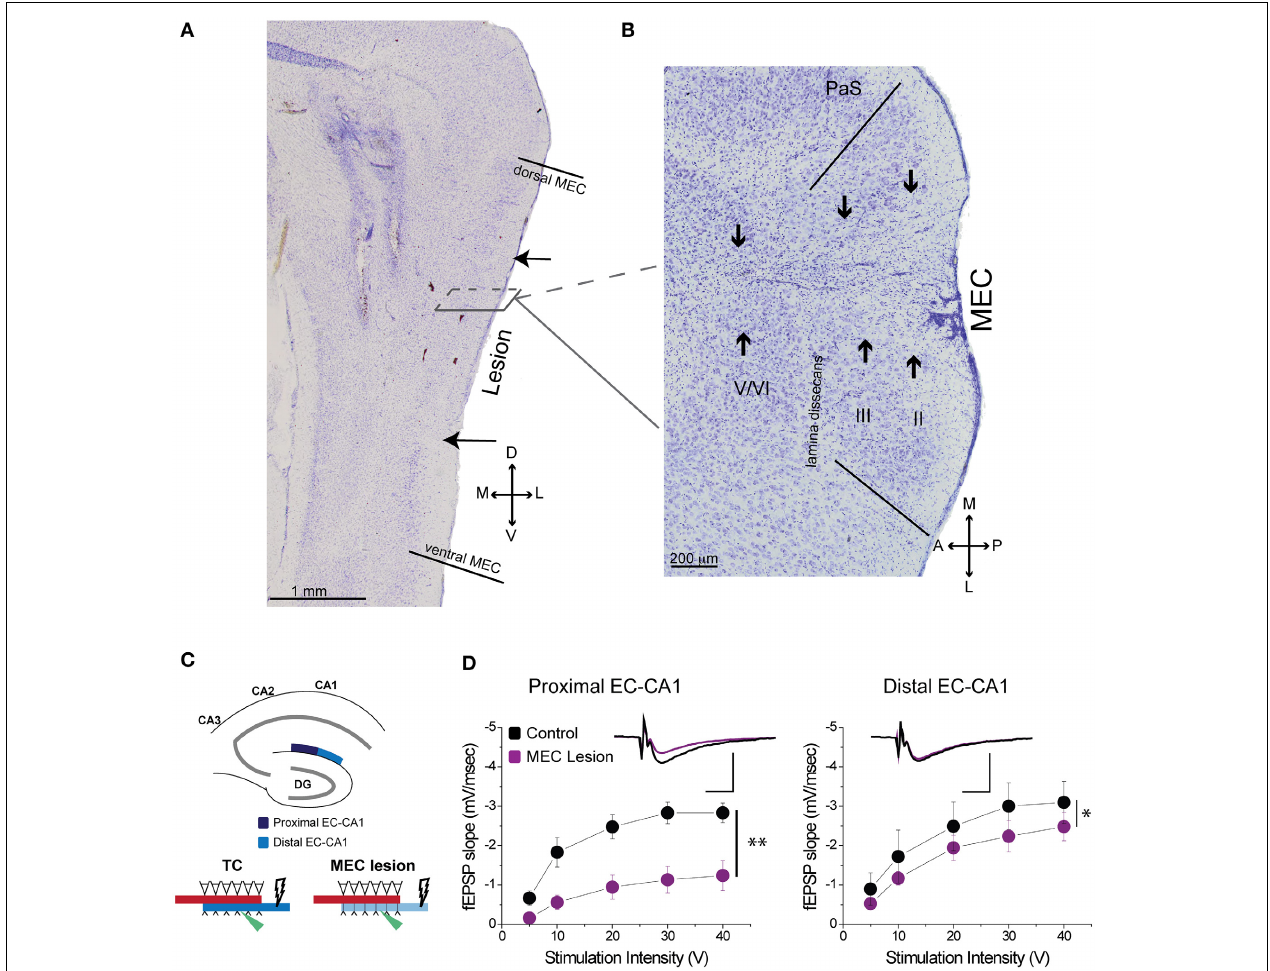
FIGURE 3 | MEC lesions diminished EC-CA1 synaptic transmission in the proximal CA1. (A) The solid lines in the sagittal section denote the dorsal and ventral edges of MEC, while the arrows indicate the dorsal and ventral bounds of the lesion. (B) In a horizontal section from a different animal the solid lines demarcate the medial and lateral bounds of MEC. The arrows indicate the main lesion for each cell layer, as determined by tissue damage and cell loss. The presence of glial cells indicates that the spread of the lesion covers most of the medial-lateral extent of MEC in this case. (C) MEC lesions